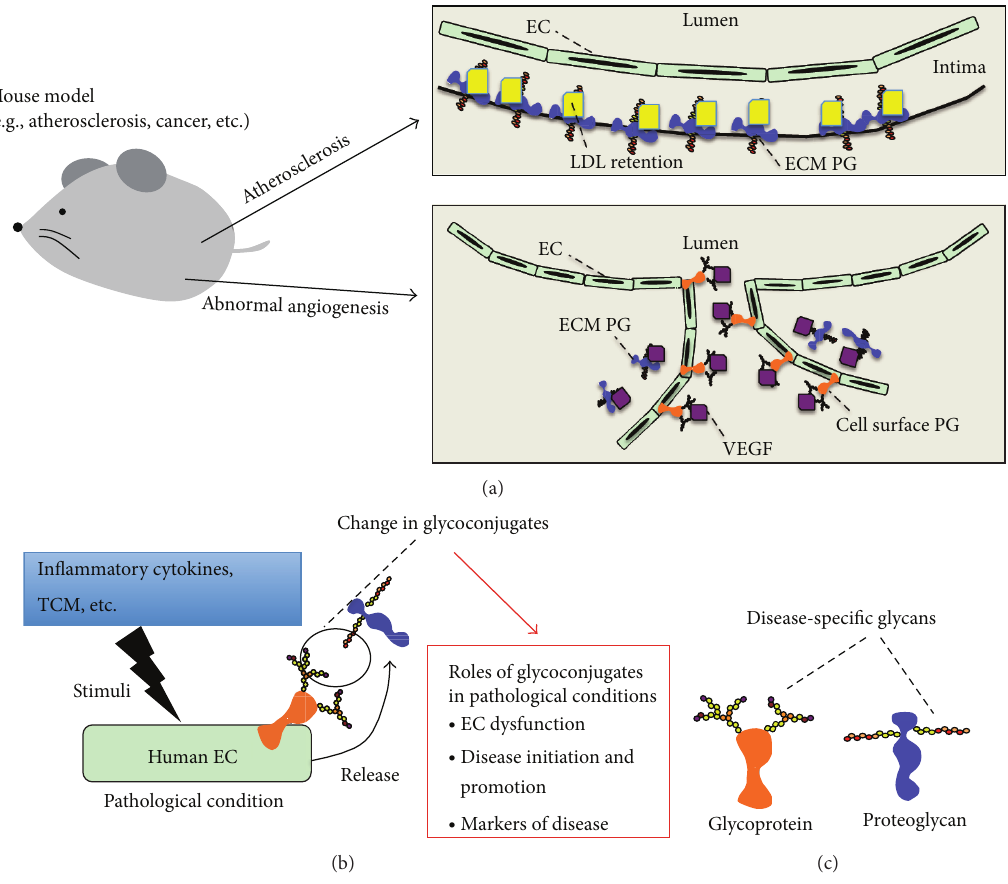
Figure 2: Glycoconjugates and peripheral artery disease (PAD). (a) The contribution of glycoconjugates to vascular-related diseases has been examined in mouse models. Initiation and promotion of atherosclerosis via interaction between LDL and proteoglycans (PGs) have been indicated. Additionally, the importance of the interaction between growth factors (e.g., VEGF165) and heparan sulfate PG in ECs and extracellular matrix (ECM) during abnormal angiogenesis, such as in tumorigenesis, has been shown. (b) In human ECs, pathological stimulation, such as inflammatory cytokines and tumor-cell-derived medium (TCM), induces changes in glycoconjugates (e.g., expression levels, glycan structures, etc.). These changes may lead to EC dysfunction and disease initiation and promotion. Furthermore, glycoconjugates specifically modified under pathological conditions may be candidates for markers of PAD. (c) Study of human ECs to identify specific glycoconjugates related to PAD may be a good strategy for the prevention and treatment of